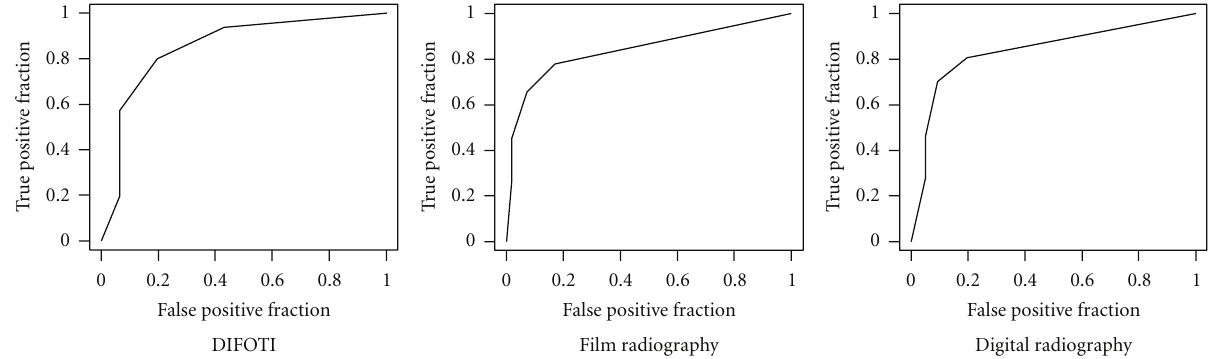
validation were 0.86, 0.87, and 0.91. The κ w agreement between histopathology and microradiography was 0.82.